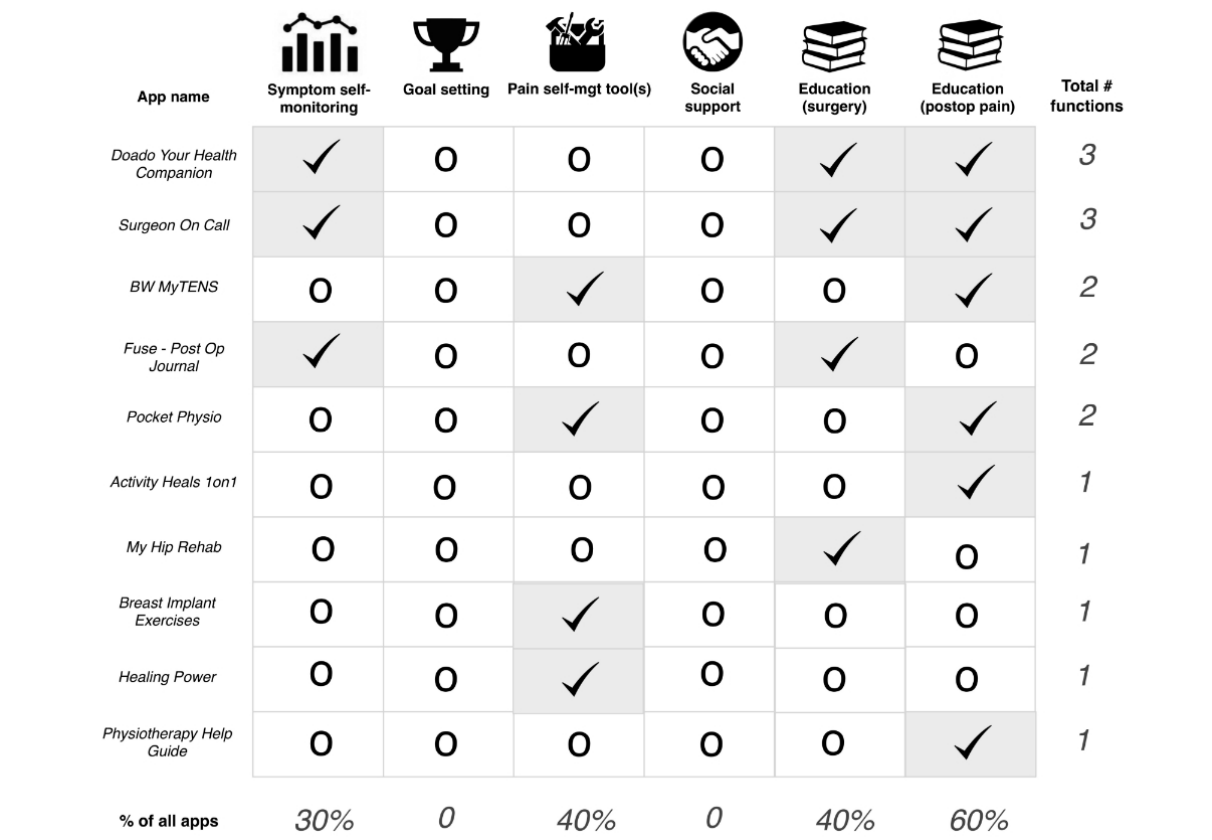
Figure 2. Self-management content across reviewed apps.